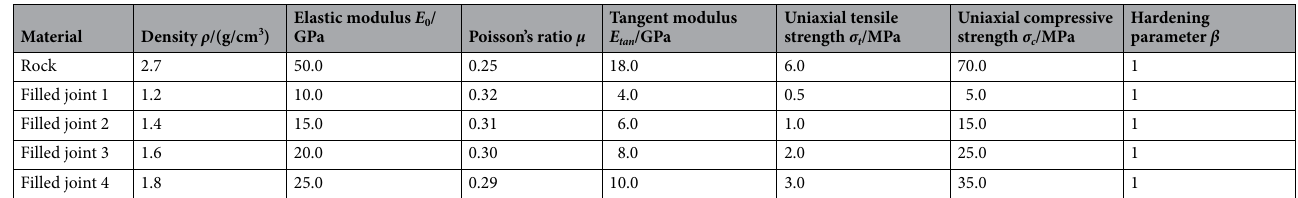
Table 5. Physical and mechanical parameters of the rock and filled